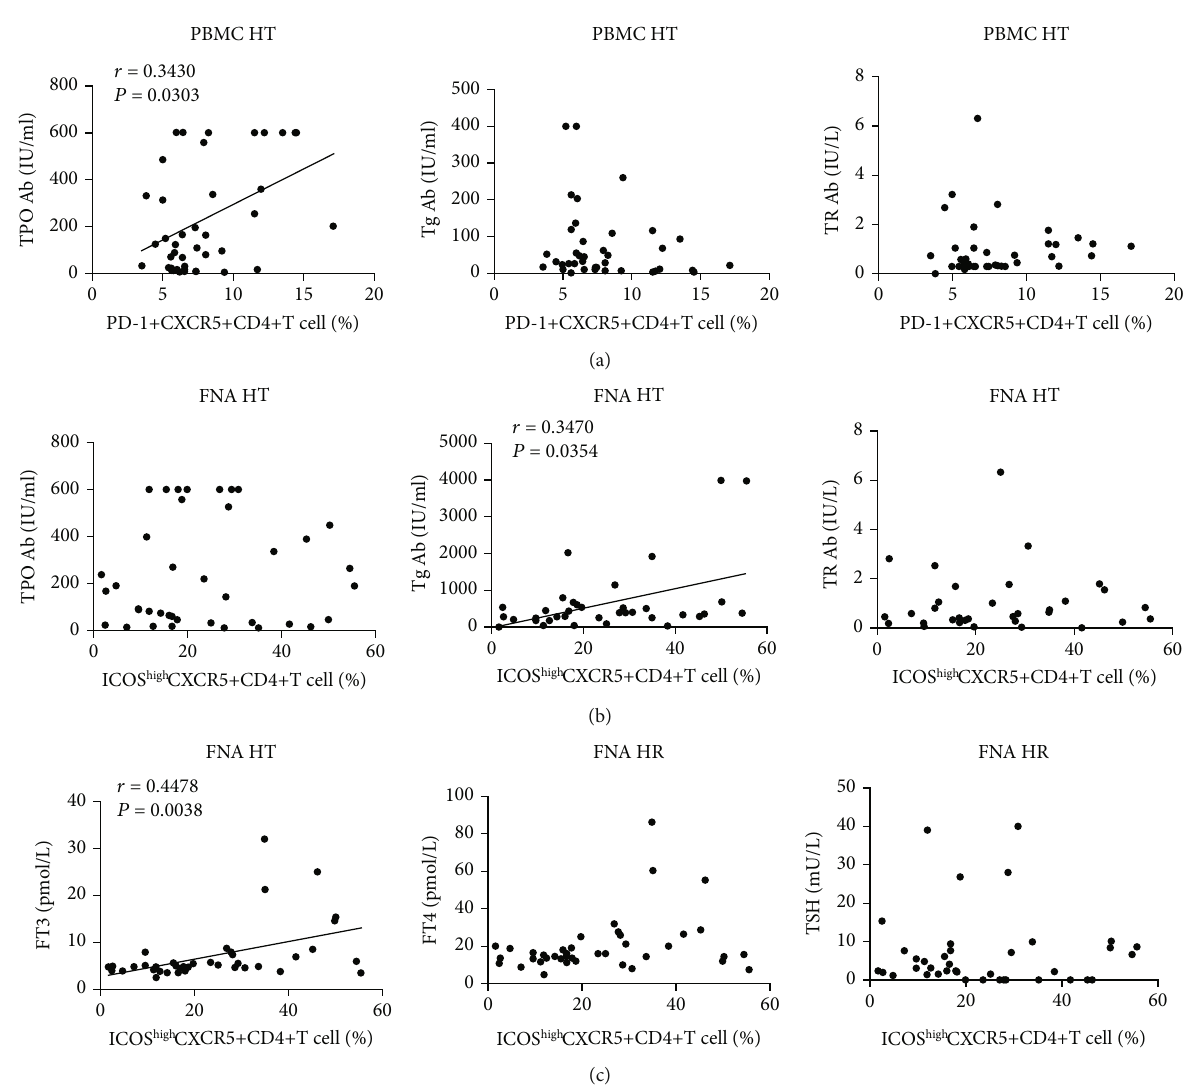
Figure 4: Correlations between Tfh cells and autoantibodies or thyroid function in HT patients. (a) Correlation between the frequency of circulating CD4 + CXCR5 + PD-1 + Tfh cells and the levels of autoantibodies in HT patients. (b) Correlation between the frequency of intrathyroidal CD4 + CXCR5 + ICOS high Tfh cells and the levels of autoantibodies in HT patients. (c) Correlation between the frequency of intrathyroidal CD4 + CXCR5 + ICOS -high Tfh cells and the levels of FT3, FT4, and TSH in HT